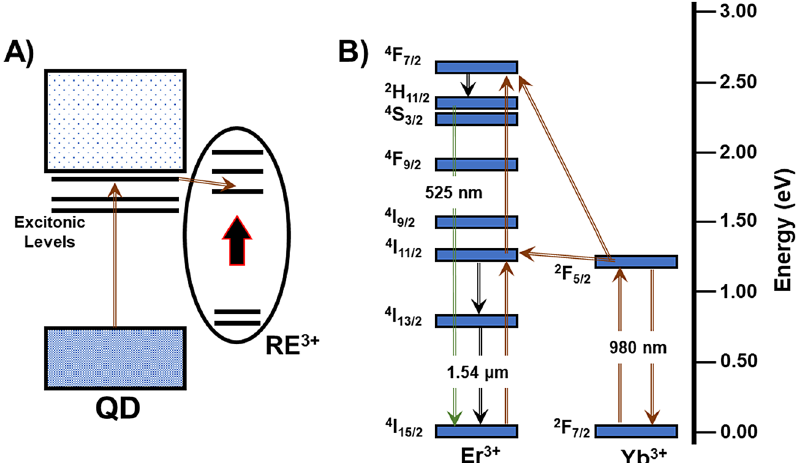
Figure 3: (A) Quantum dot (QD) sensitized rare earth (RE) excitation. (B) Upconversion scheme for Yb 3 + sensitized Er 3 +